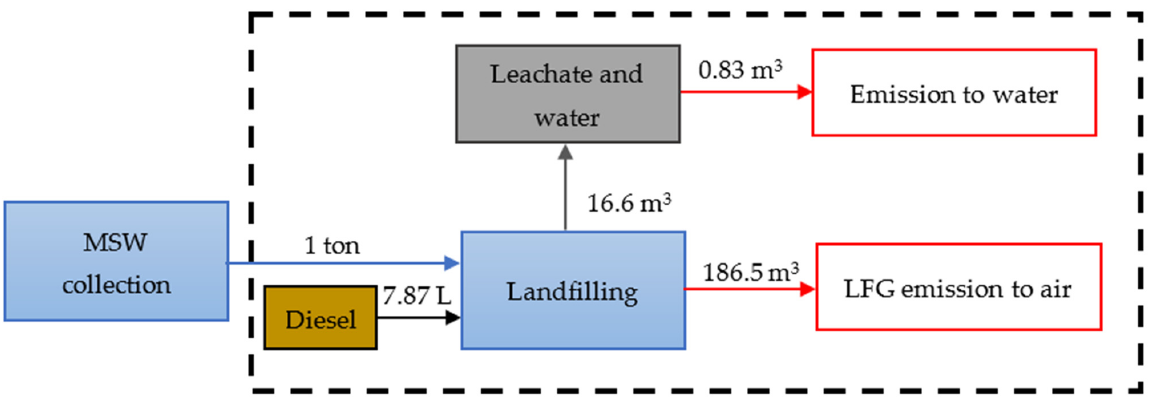
Figure 1. Landfilling process flow diagram.